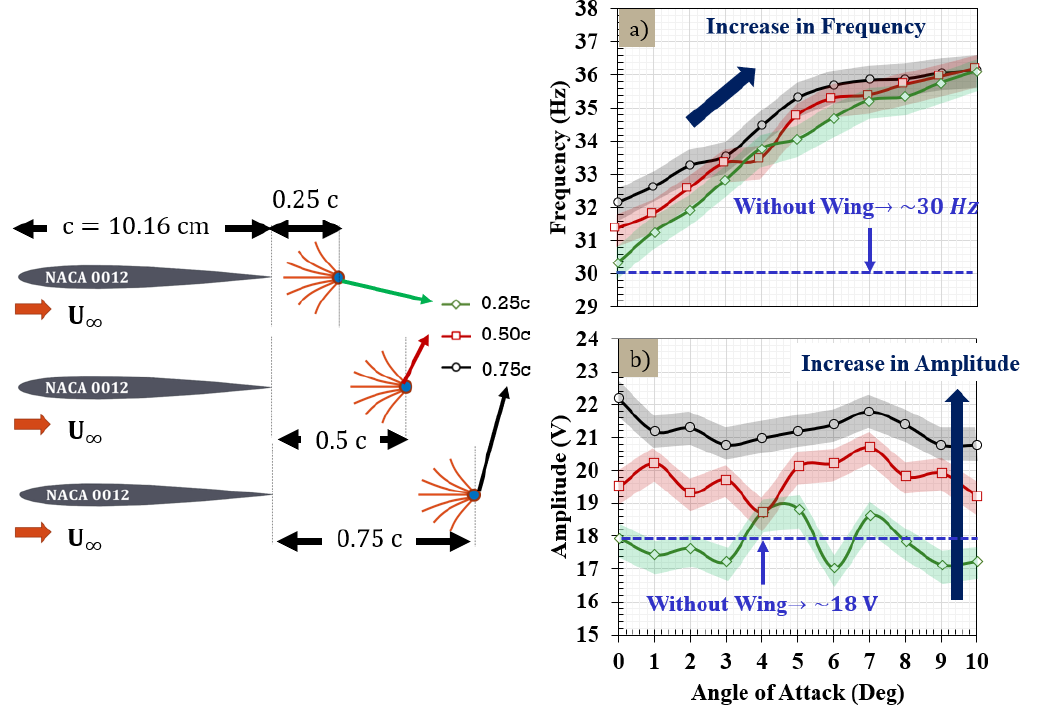
Figure 14. Variation of ( a ) frequency and ( b ) amplitude of the PVDF oscillations with angle of attack at different downstream locations. The frequency increases with an increase in angle of attack, but the amplitude remains constant. However, both the frequency and the amplitude increase with increase in downstream